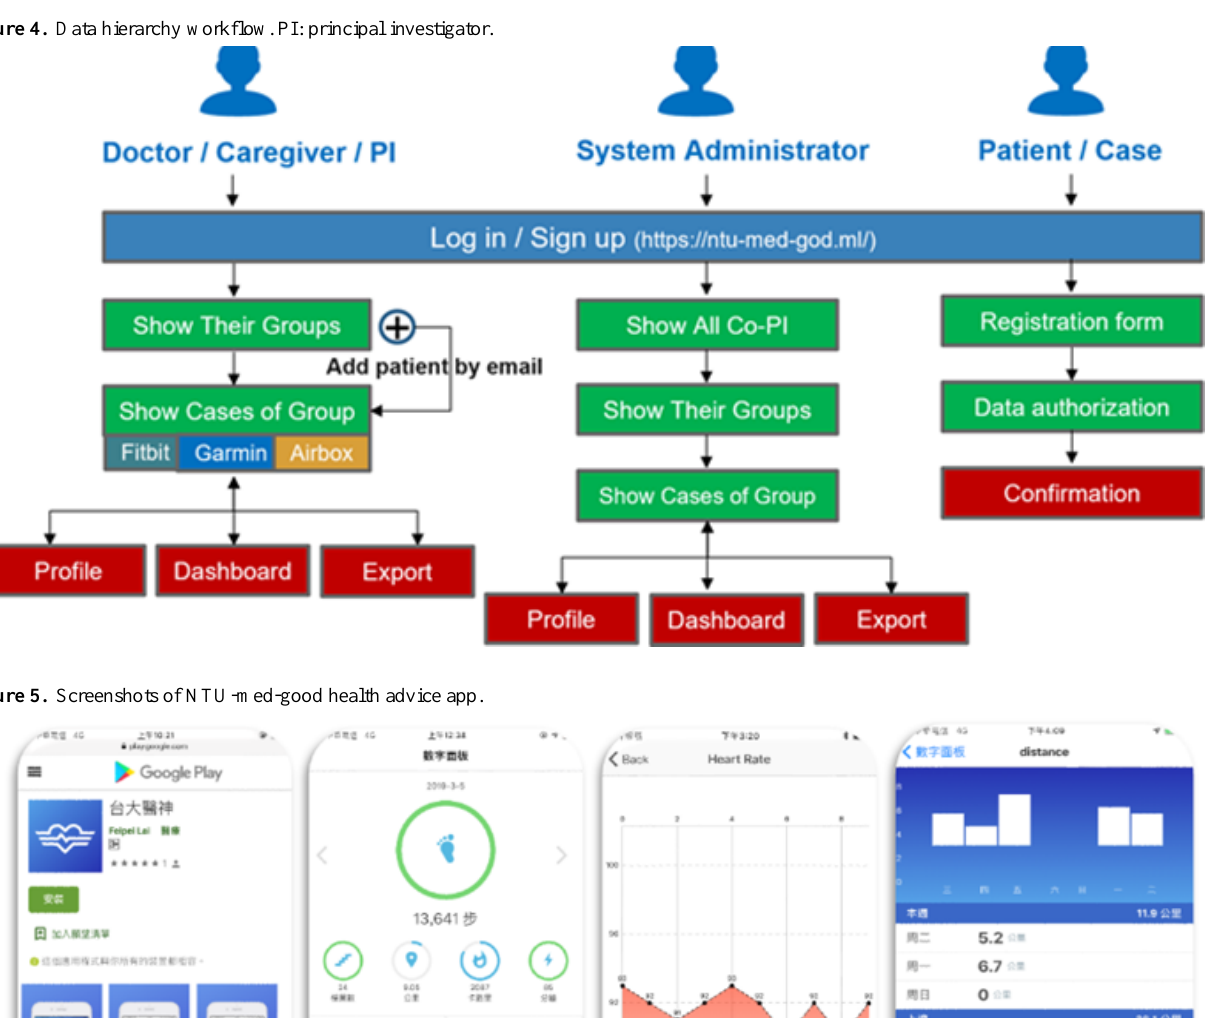
Figure 4. Data hierarchy workflow. PI: principal investigator.